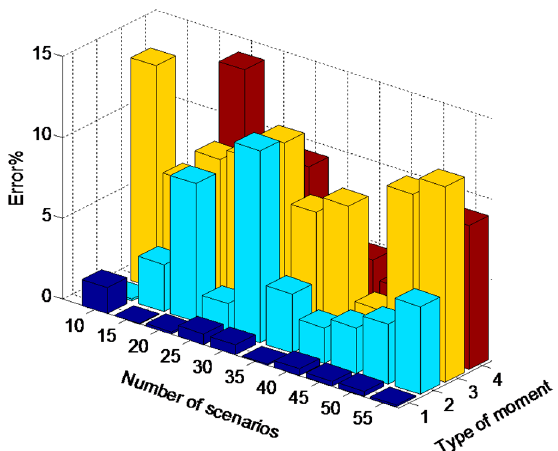
Figure 5. Moments errors of generated scenarios. Type of moment: (1) Expectation; (2) Standard deviation; (3) Skewness; (4) Kurtosis.